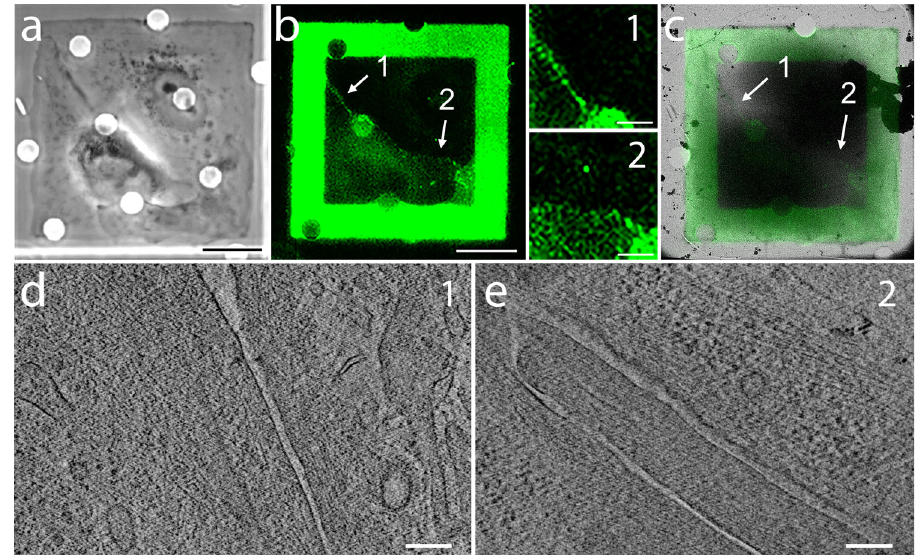
Fig. 5 | Correlative light and cryo-EM/ET visualization of cell – cell contacts in PTK-1cellsadheringtomicropatterns. PTK-1cellsstablyexpressingEGFP-alphaE catenin were plated on micropatterned grids treated with Oregon Green gelatin. Upon adhesion, many cells form doublets con fi ned into the pattern, as shown in this example. a Phase contrast, b fl uorescence image of the cell pair of interest, displaying both the EGFP signal from the tagged alpha E catenin and the Oregon Greensignalmarkingthepattern.Notethatthepatternsignalintensityisinherently much higher than that of the tagged protein, somewhat overwhelming the EGFP identi fi ableby theEGFP-alphaE catenin signal.With the patternedarea of the grid restricted to the central 10 ×10 squares, this percentage results in 9 – 23 candidates per grid for further analysis.